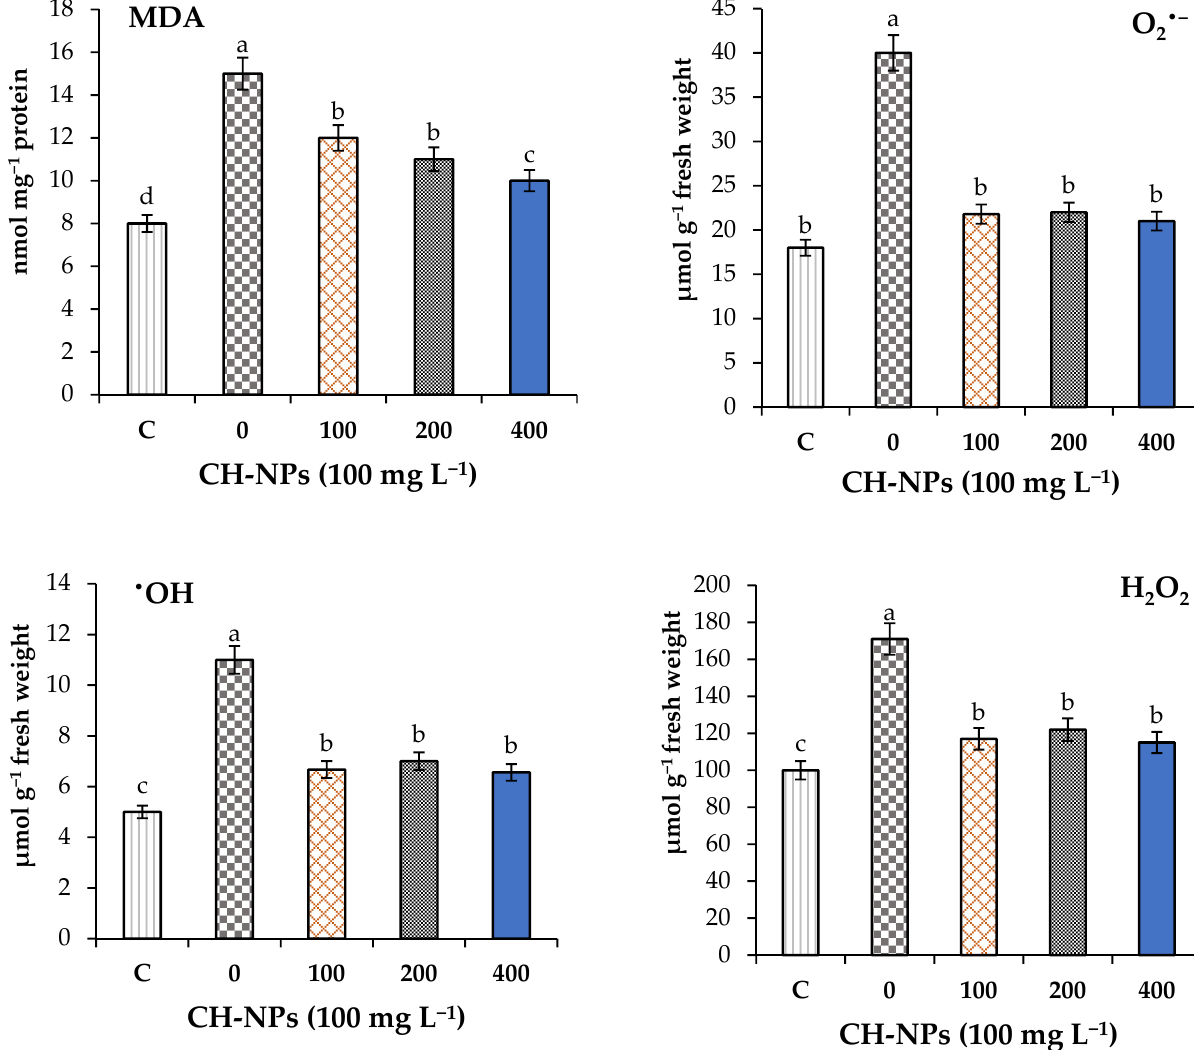
Figure 3. Effects of chitosan nanoparticles (CH-NPs) on malondialdehyde (MDA) and reactive oxygen species (superoxide anions (O 2 •− ), hydroxyl radicals ( • OH), and hydrogen peroxide (H 2 O 2 )). C = control treatment without cold stress and without CH-NP amendment. Different letters refer to significant differences between treatments according to Tukey’s test at p < 0.05. Each value is the mean of five replicates (mean ± SD, n = 5). The highest significant values ( p < 0.05) for MDA and ROS were recorded in banana plants exposed to cold stress (5 °C for 72 h) without the addition of CH-NPs. Foliar appli- cation of chitosan nanoparticles (CH-NPs) significantly decreased MDA and ROS in the leaf tissue of banana plants grown under cold stress. Spraying banana plants with 100 mg L − 1 of CH-NPs decreased the MDA, H 2 O 2 , • OH, and O 2• − by 20, 32, 39, and 46%, respec- tively, compared to the unsprayed plants. Spraying banana plants with 200 mg L − 1 of CH-